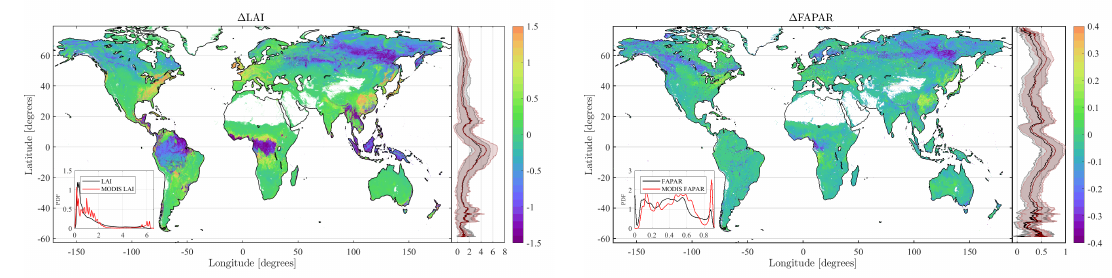
Figure 9. LAI and FAPAR global maps and latitudinal transects corresponding to the difference of mean values between derived estimates by the proposed retrieval chain and the GEE MODIS reference product for the period 2010–2015.